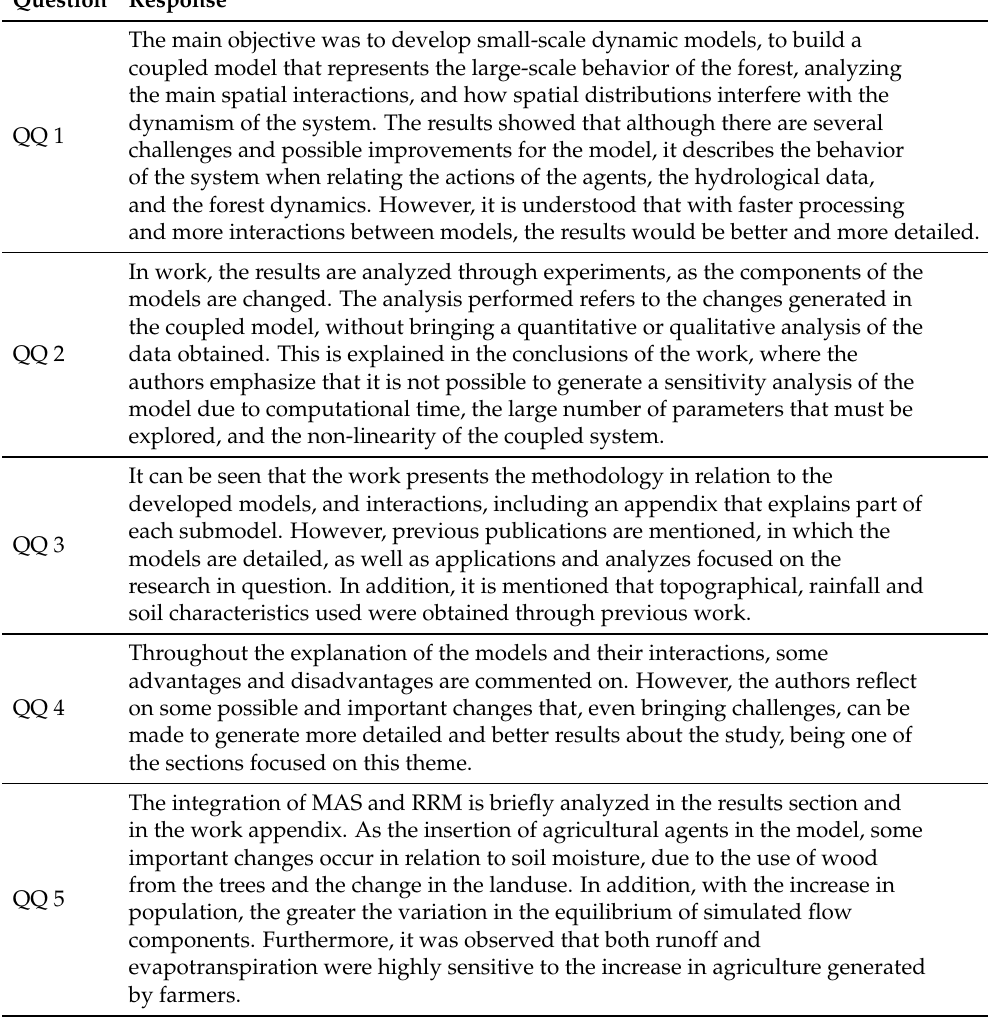
Table A2. Answers of quality questions about the work of Bithell and Brasington [78]. Question